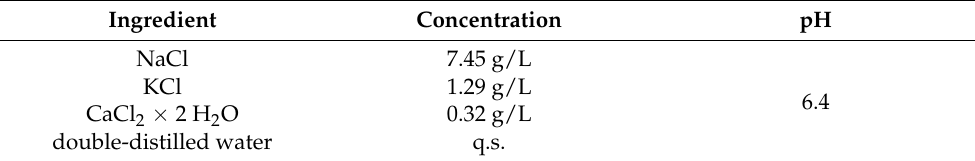
Table 2. Composition of simulated nasal fluid